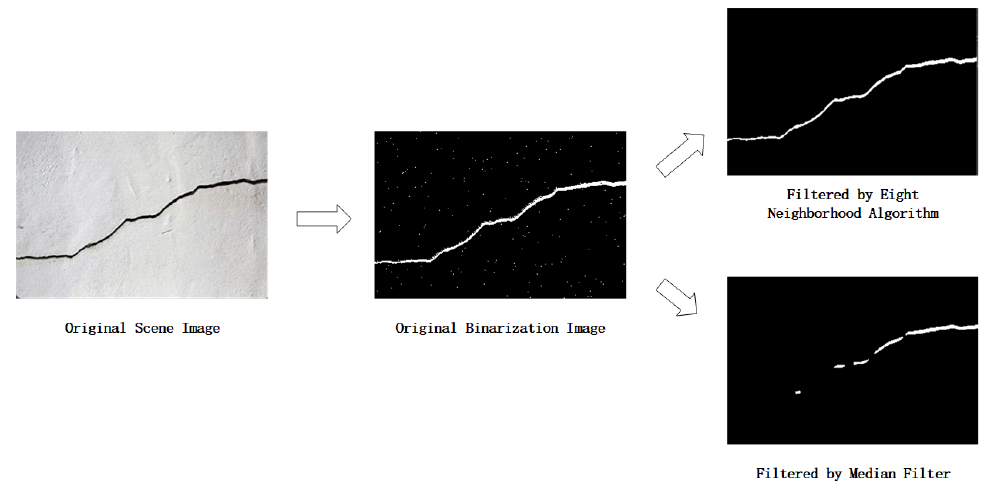
Figure 10. Narrow crack filtering